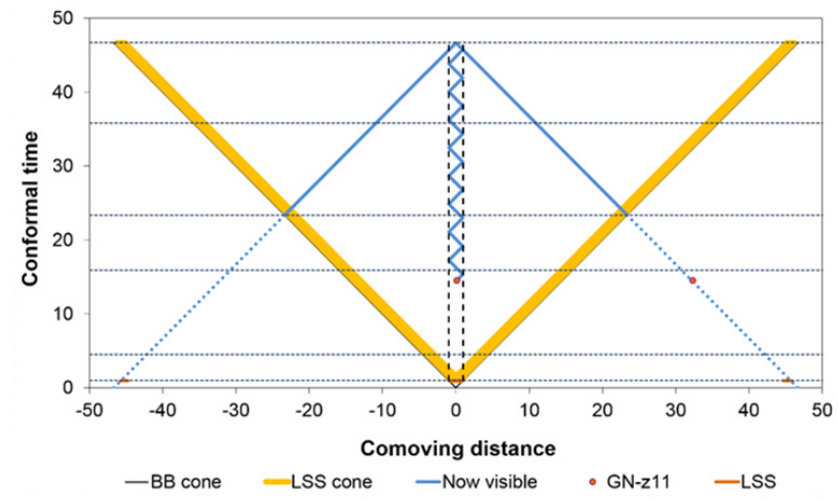
Figure 1. Spacetime diagram of a flat Big Bang universe. Abscissa: comoving distance χ in Glyr. Ordinate: conformal time η in Gyr. V-like golden band: the future light cone of the last scattering surface (LSS, the red horizontal dash close to the zero-point, visible directly only from within the golden band). Blue Λ-like trace: our past light cone – we are located at its peak, not in the golden band. The region beyond the golden band (dotted extension of the blue trace) has not come into existence. In standard cosmology, the galaxy GN-z11 and a fictitious LSS are placed in this region nevertheless (the latter at χ ≈ ±46 Glyr). Between the dashed vertical lines: a confined universe that co-expands with the material universe (co-moving diameter constant and equal to that of the LSS, mentioned under model 2). So confined, the LSS remains permanently visible. The place of GN-z11 in this model and a zigzag path to us via 17 reflections is also shown. Dotted horizontal lines: see Table 1. Last scattering at η ≈ 0.95 Gyr, t ≈ 0.38 Myr; last visibility of the LSS and last blackbody conditions at η ≈ 1.9 Gyr, t ≈ 1.95